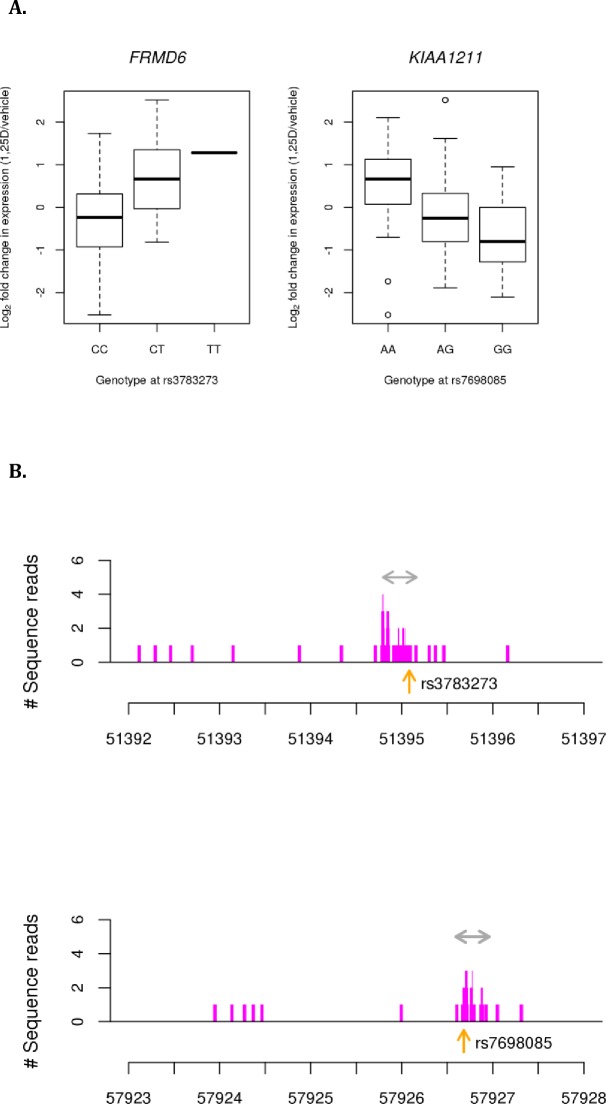
Associations between SNPs in vitamin D receptor (VDR) binding sites and transcriptional response.(A) Boxplots showing the effect of genotype on log2 fold change of FRMD6 and KIAA1211 transcript levels, with genotypes of the associated SNPs on the x-axis. (B) Location of SNPs associated with transcription response of FRMD6 (rs3783273, top panel) and KIAA1211 (rs7698085, bottom panel) within VDR binding sites, indicated by the gray horizontal arrows. The SNP locations are indicated by the vertical orange arrows. VDR binding site information was obtained from a published ChIP-seq dataset from THP-1 monocytic cells treated with 1,25D and bacterial lipopolysaccharide (LPS).